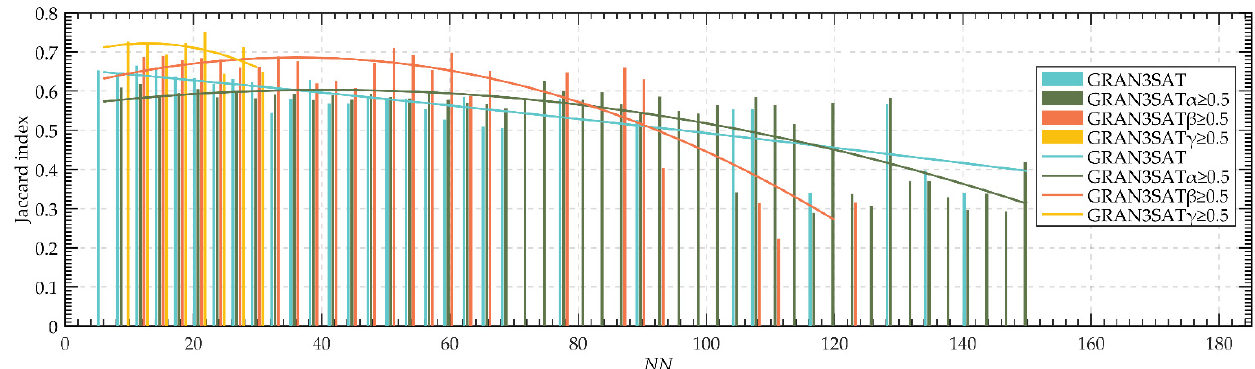
Figure 5. S for different GRAN3SAT models. Figure 5. S Jaccard Jaccard for different GRAN3SAT